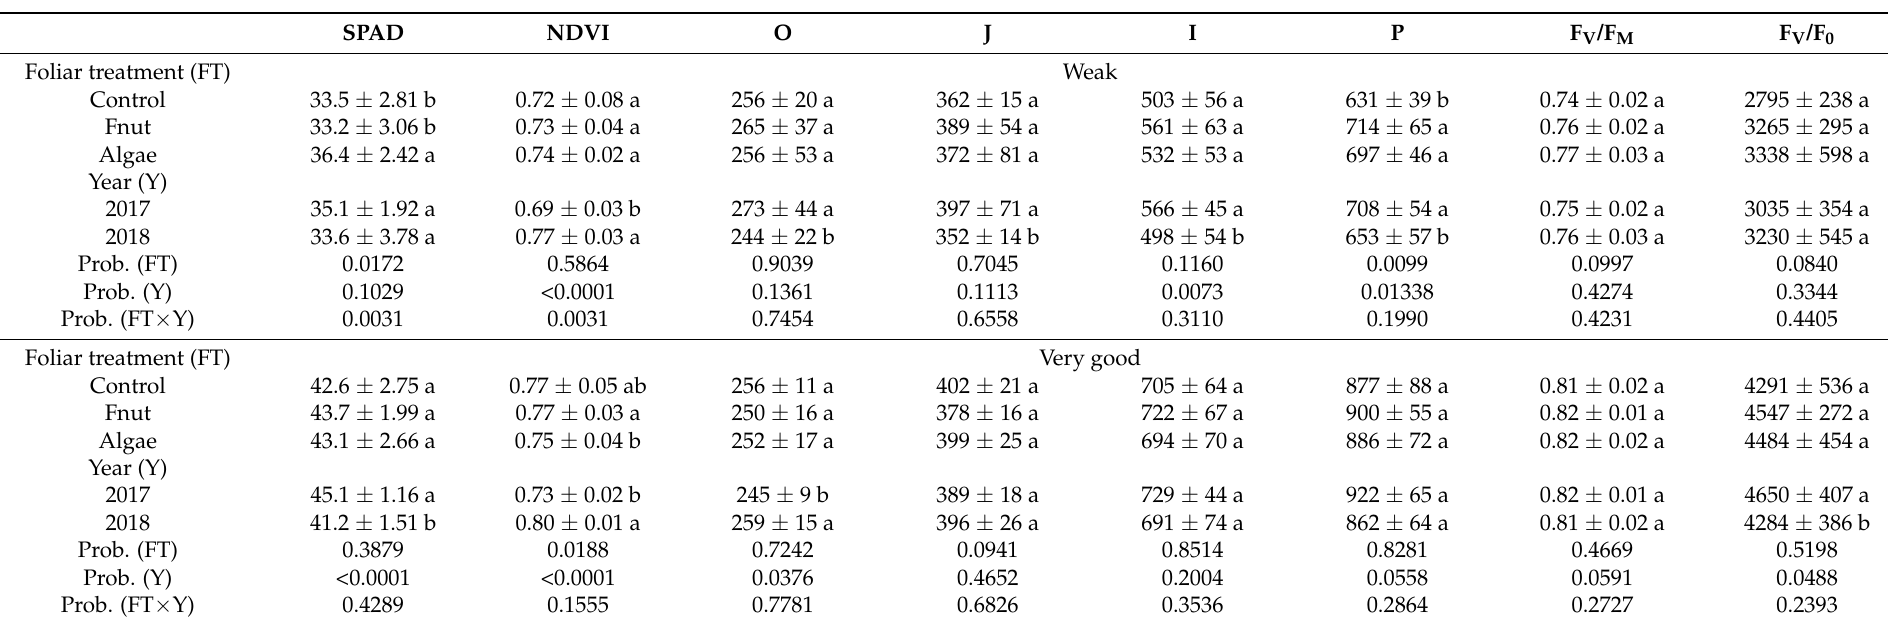
Table 4. SPAD (Soil and Plant Analysis Development) readings, NDVI (Normalized Difference Vegetation Index) and chlorophyll a fluorescence (average ± standard error) on July in the plots of weak and very good vigour plants as a function of foliar treatment (Fnut, nutrient-rich foliar spray; Algae, algae-rich foliar spray; and Control) and year. Means followed by the same letter are not statistically different ( α = 0.05) by Tukey HSD tests (Foliar treatment) or Student’s t -tests